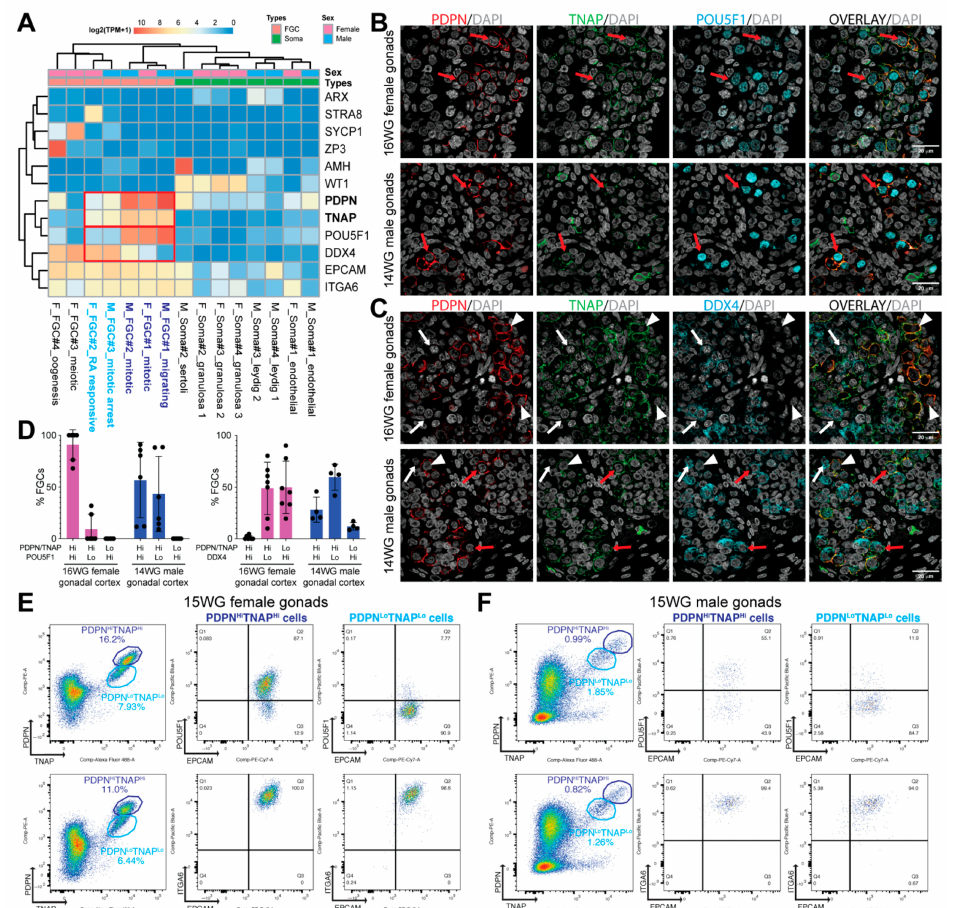
Figure 1. Expression of cell surface markers in male and female human fetal gonads. ( A ) Heatmap generated using existing data [7] showing expression of several genes of interest in male and female fetal germ cells (FGCs) and gonadal somatic cells (soma). ( B ) Histological sections of 16 WG female gonads and 14 WG male gonads immunostained for PDPN, TNAP and POU5F1. Red arrows indicate cells positive for PDPN, TNAP and POU5F1. Scale bars are 20 µ m. ( C ) Histological sections of 16 WG female gonads and 14 WG male gonads immunostained for PDPN, TNAP and DDX4. Red arrows indicate cells positive for PDPN, TNAP and DDX4, white arrows indicate cells positive for DDX4; arrowheads indicate cells positive for PDPN and TNAP. Scale bars are 20 µ m. ( D ) Quantification of male and female FGCs in 16 WG female gonads and 14 WG male gonads regarding expression of PDPN, TNAP and POU5F1 (left) and PDPN, TNAP and DDX4 (right). The individual percentages are given (black circles) as well as mean ± standard deviation. ( E ) FACS plots showing expression of PDPN/TNAP in female 15 WG gonads. The expression of POU5F1/EPCAM (top panel) and ITGA6/EPCAM (bottom panel) are shown for the PDPN/TNAP high (Hi) and low (Lo) populations. ( F ) FACS plots showing expression of PDPN/TNAP in male 15 WG gonads. The expression of POU5F1/EPCAM (top panel) and ITGA6/EPCAM (bottom panel) are shown for the PDPN/TNAP high (Hi) and low (Lo)